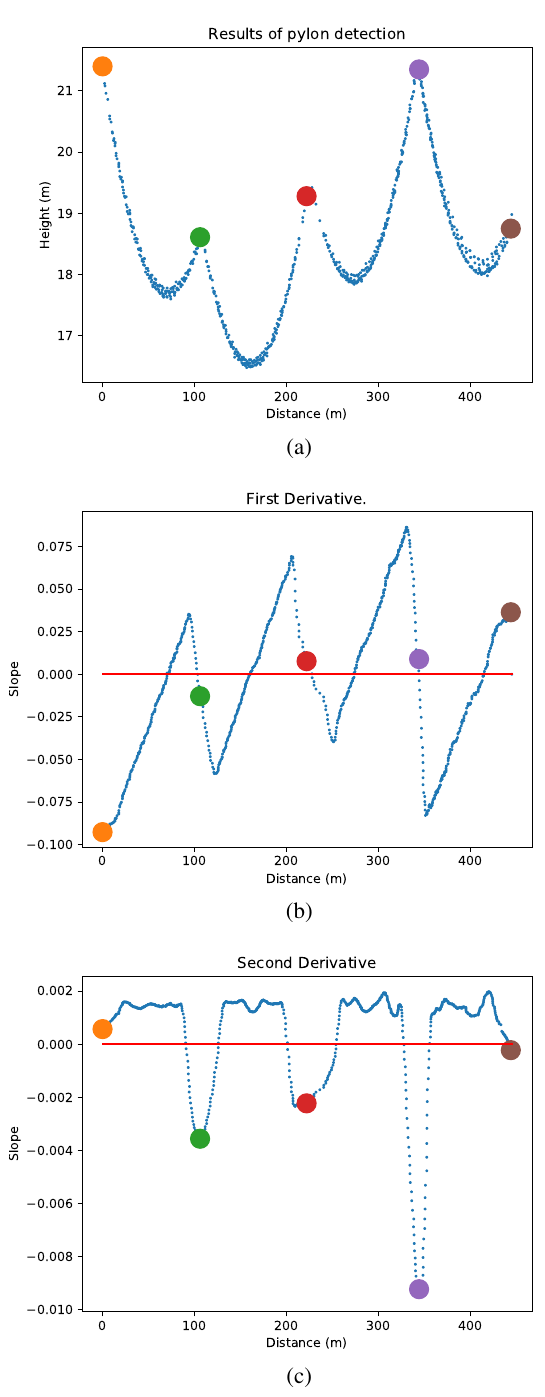
Figure 9. Pylon detection